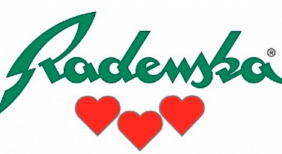
Figure 3. Radenska ® brand name, used in the word-association